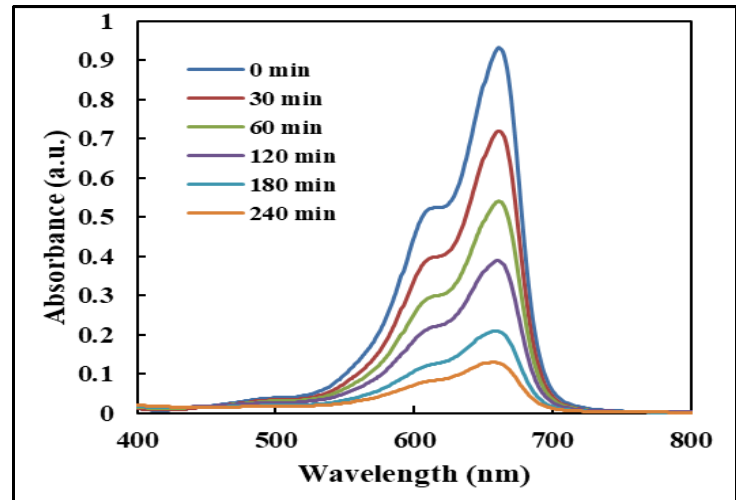
Figure 6: UV-Vis. absorption spectra of MB (5ppm) catalysis by 3g/40 ml for ZnO/epoxy nanocomposite (2wt.%).